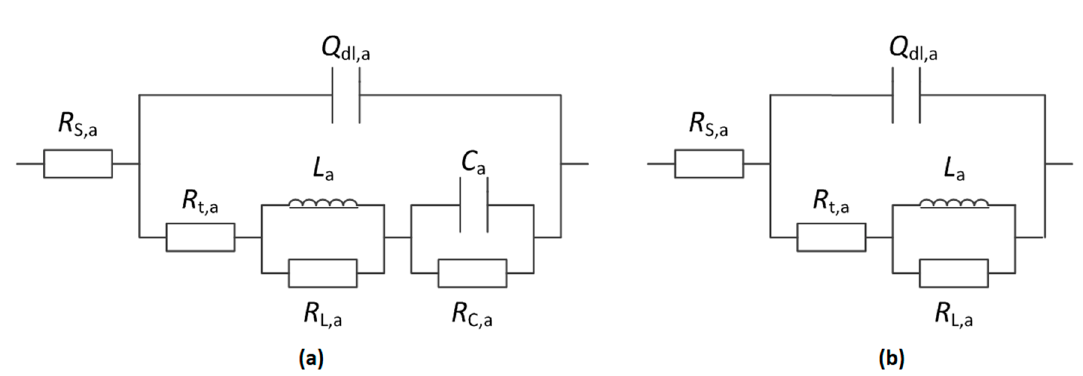
Figure 8. Equivalent circuit model for fitting the EIS measured at +60 mV (vs. OCP) under different ( a ) elastic and ( b ) plastic tensile stress at 30 ◦ C. Table 3. Electrochemical impedance spectroscopy (EIS) parameters of X80 steel obtained by fitting the EIS curves of X80 steel measured at +60 mV (vs. OCP) in 3.5 wt% NaCl aqueous solution with saturated CO 2 under elastic tensile stress at 30 °C.